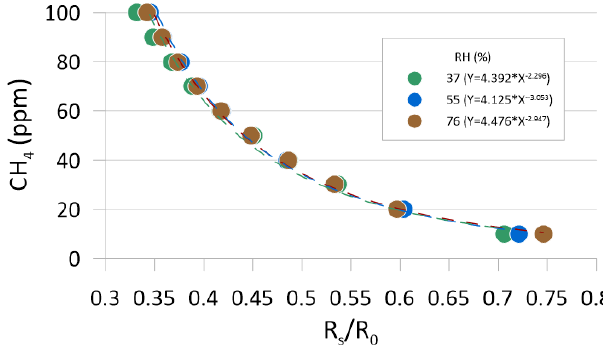
Figure 5. Resistance ratio of MOS as three levels of relative hu- midity at CH 4 concentration levels between 10 and 100ppm CH 4 in humidified synthetic